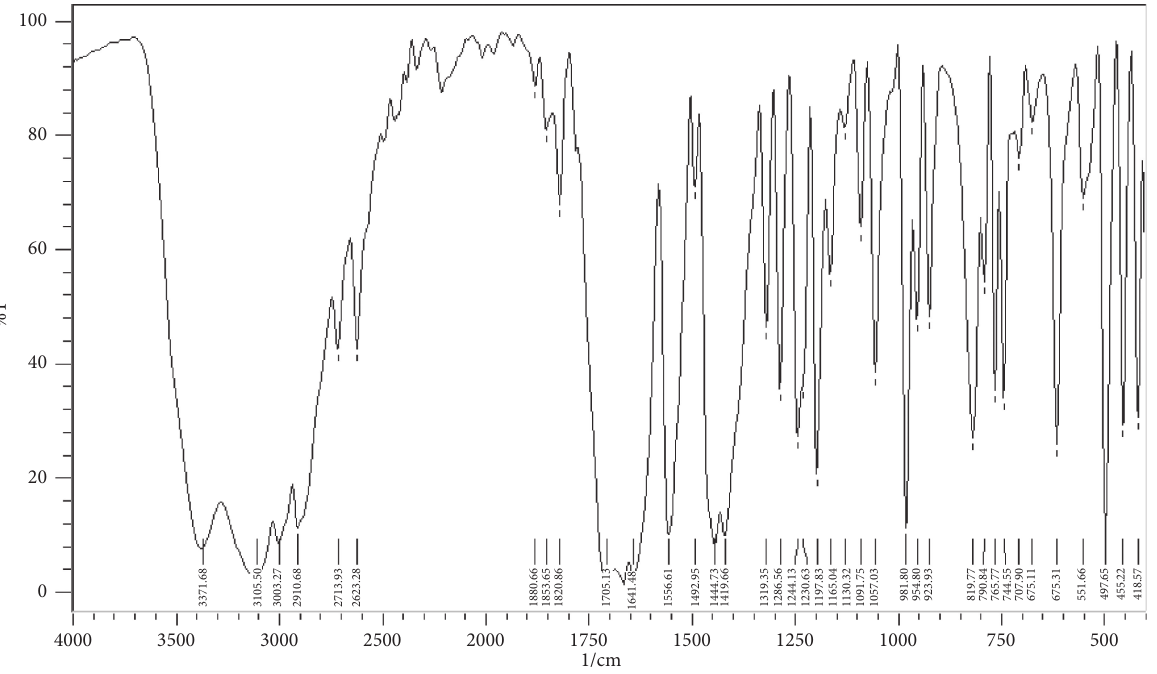
Figure 8: Infrared spectrum of CPAT as KBr disk.